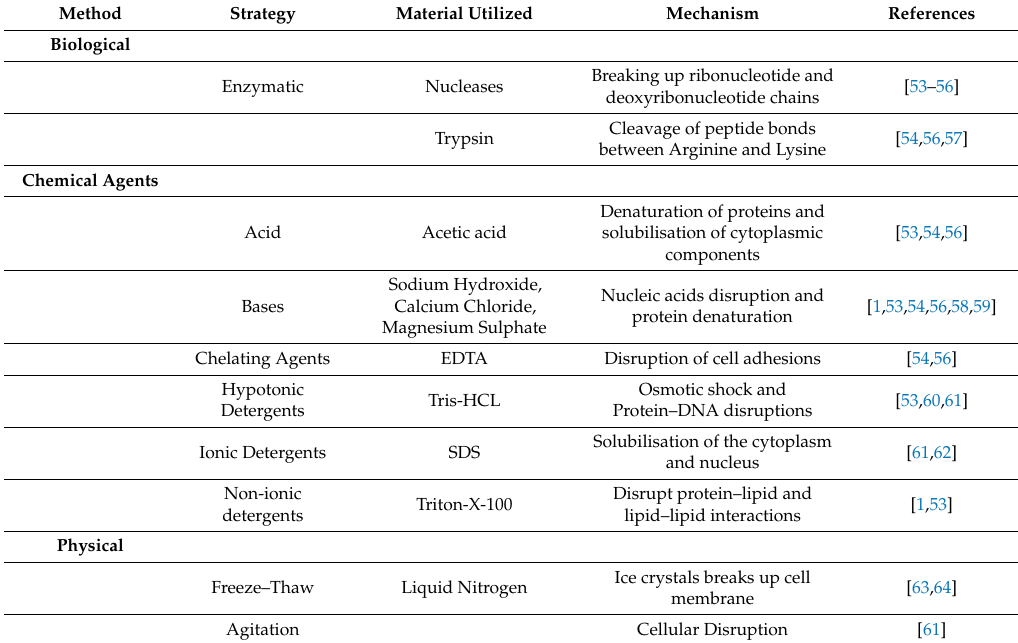
Table 1. Various decellularizing strategies used to produce